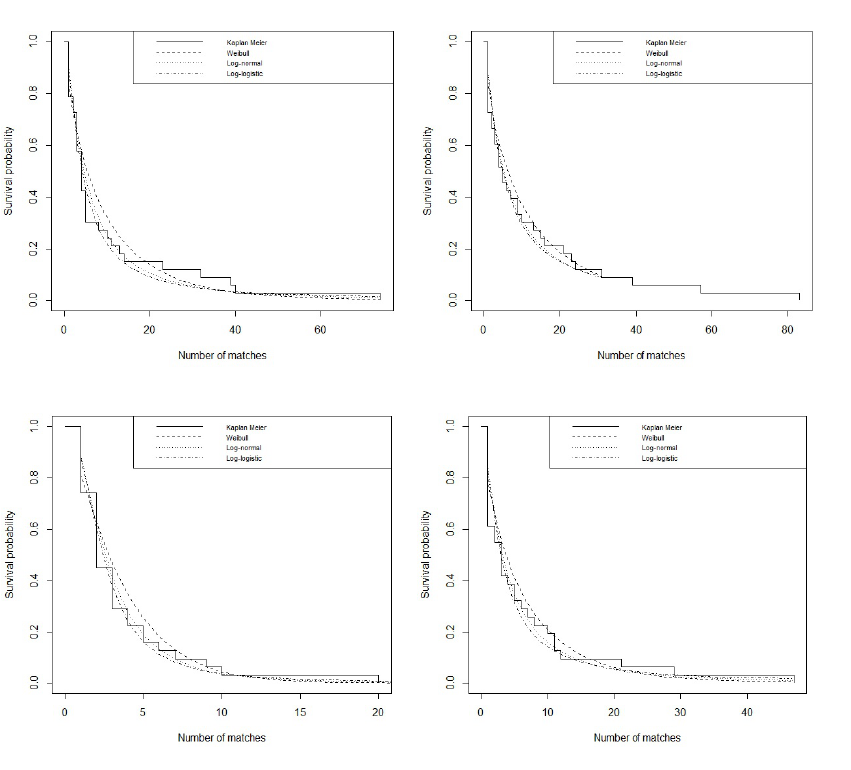
Figure 2 – Plots for the 1 st cycle comparing the fitted log-normal, Weibull and log-logistic curves with the Kaplan Meier curve (in the order batsmen inclusion and exclusion and bowler inclusion and exclusion, clockwise from upper